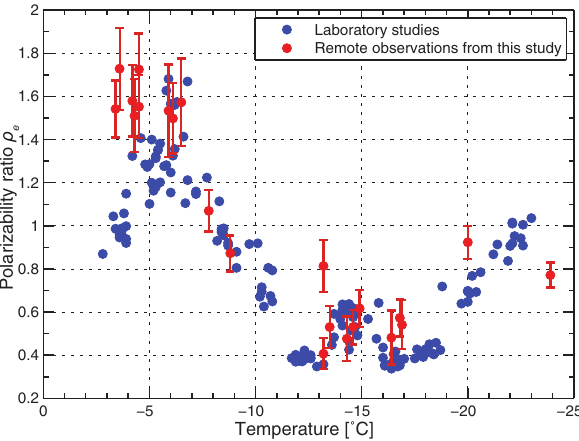
Figure 8. Temperature dependence of geometrical axis ratio for par- ticles grown in the free-fall cloud chamber (Takahashi et al., 1991). Apparent density is color-coded. Note that ρ g > 1 corresponds to prolate particles and ρ g < 1 corresponds to oblate particles. Numer- ical data were provided by Prof. Takahashi, Hokkaido University of Education, Sapporo, Japan.